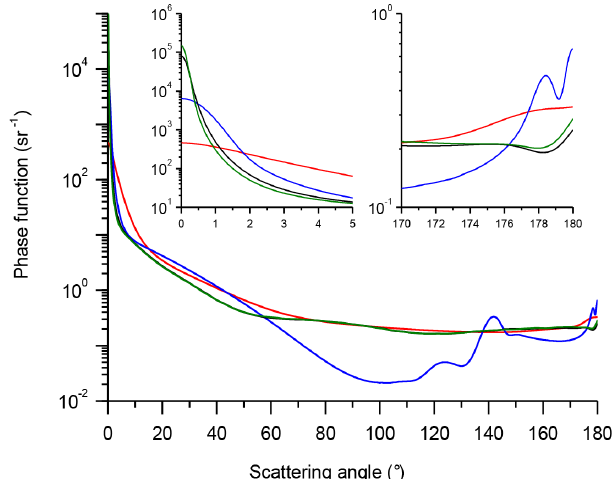
Figure 1. Normalized phase functions: coarse aerosol – red lines, water cloud – blue lines, JS cirrus – black lines, Ci cirrus – green lines.